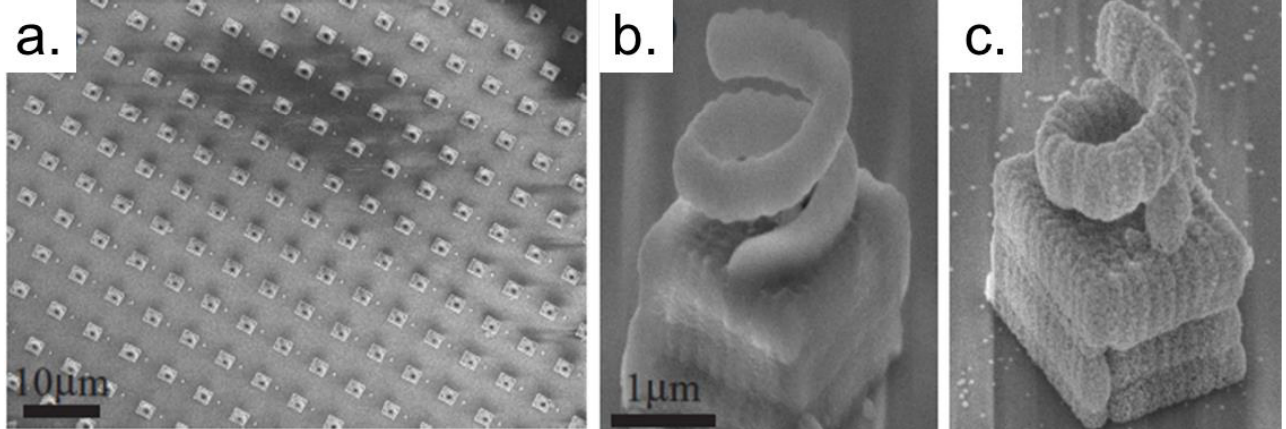
Figure 8. ( a ) 78 × 58 μm 2 SEM image of a 3D periodic silver-coated structure fabricated on a hydrophobic coated glass surface. ( b ) Tilted magnified view of an individual uncoated polymer structure composed of a cube (2 μm in size) holding up a spring (height 2.2 μm, inner diameter 1 μm). ( c ) SEM image of an individual silver coated structure after electroless plating. Reproduced with permission [90]. Copyright © 2006, The Optical Society.